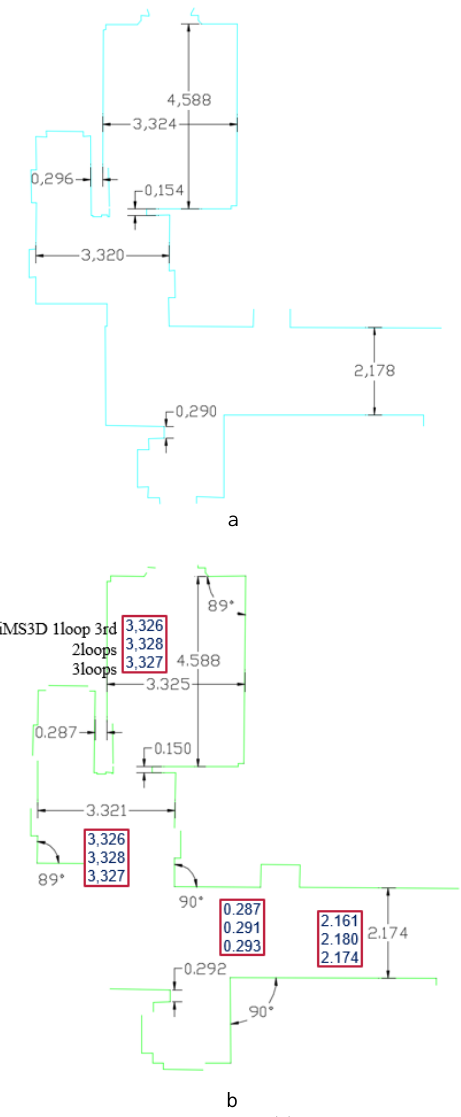
Figure 11. Model based evaluation (a), Manual measurement data (b) Model using P20 as reference and overlaid iMS3D measurements (1 loop 3 rd , 2 loops, 3